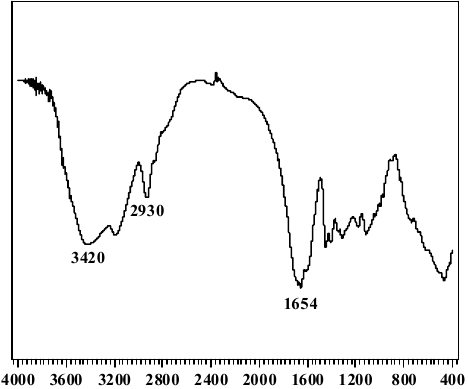
Figure 2. Plugging agent infrared spectra.